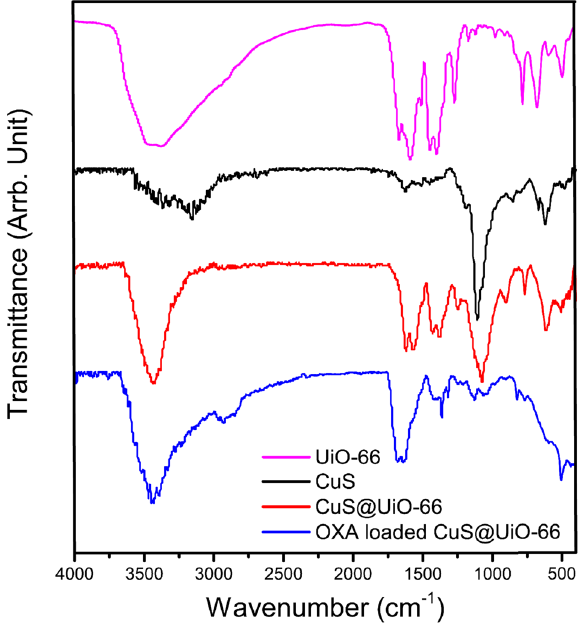
Fig. 2 FTIR Spectra of CuS, UiO-66-NH 2 , Cus@-UiO-66-NH 2 , and OXA-CuS@UiO-66-NH